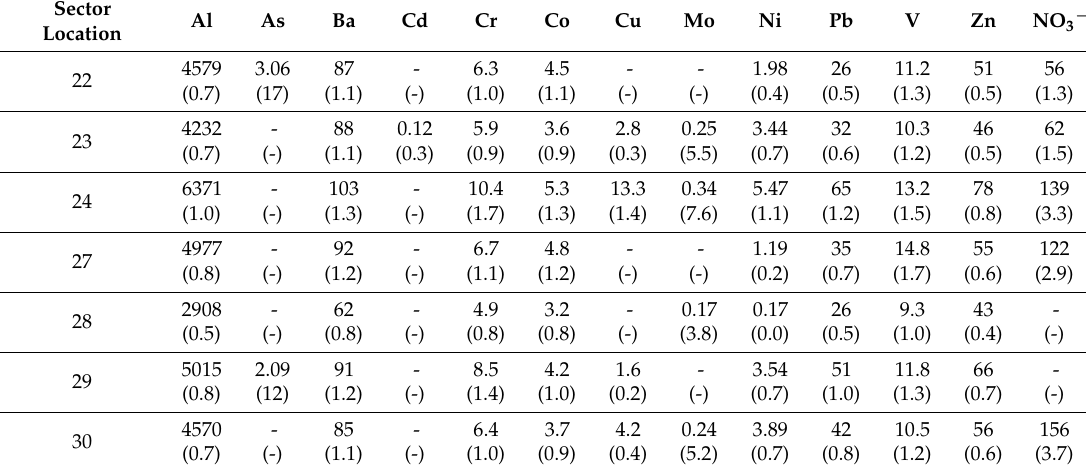
Table 5. Data for metals and NO 3 − concentrations in W